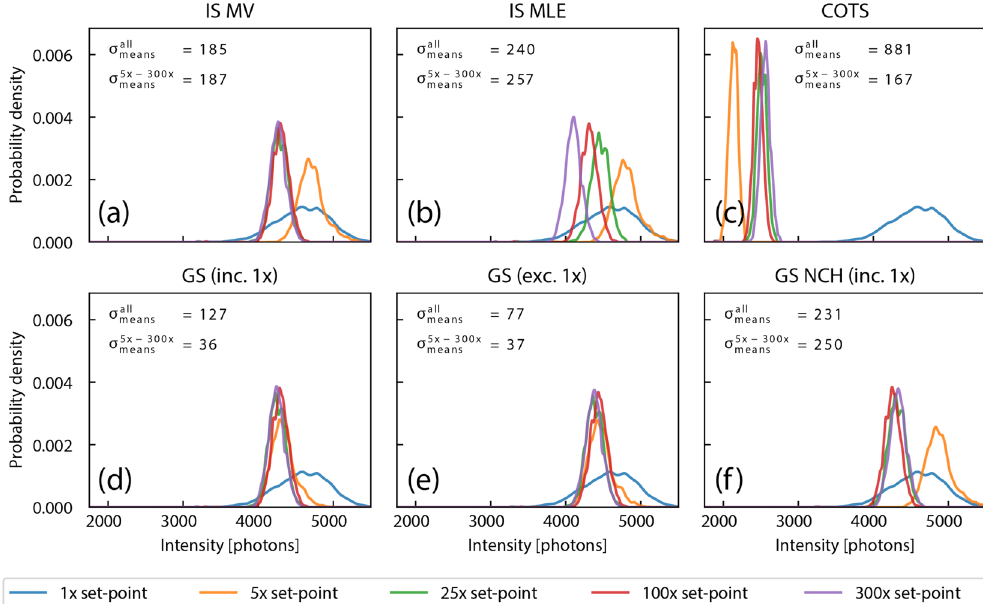
Figure 4. Consistency results from bead localization. Intensity estimations from fitting a single fluorescent bead imaged at a fixed excitation intensity at different gain set-points. Distributions are composed of fitting the same bead over multiple frames. For an ideal calibration, the distributions should overlap completely, regardless of the gain set-point. Only the gain-series methods demonstrate this consistency. The standard deviations of the distribution means, σ means , are indicated for each method (including and excluding the 1× distribution) as a metric for the performance of the various methods.